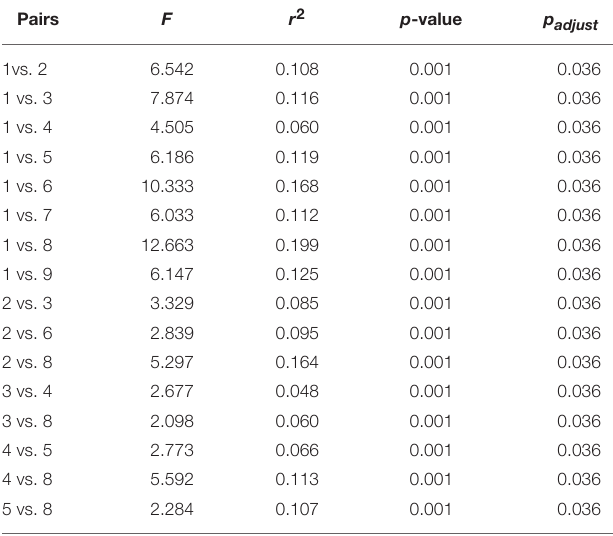
TABLE 3 | Results of PerMANOVA pairwise comparisons of community composition among the nine urban habitat types. Refer to Figure 4 for definitions of the nine urban habitat